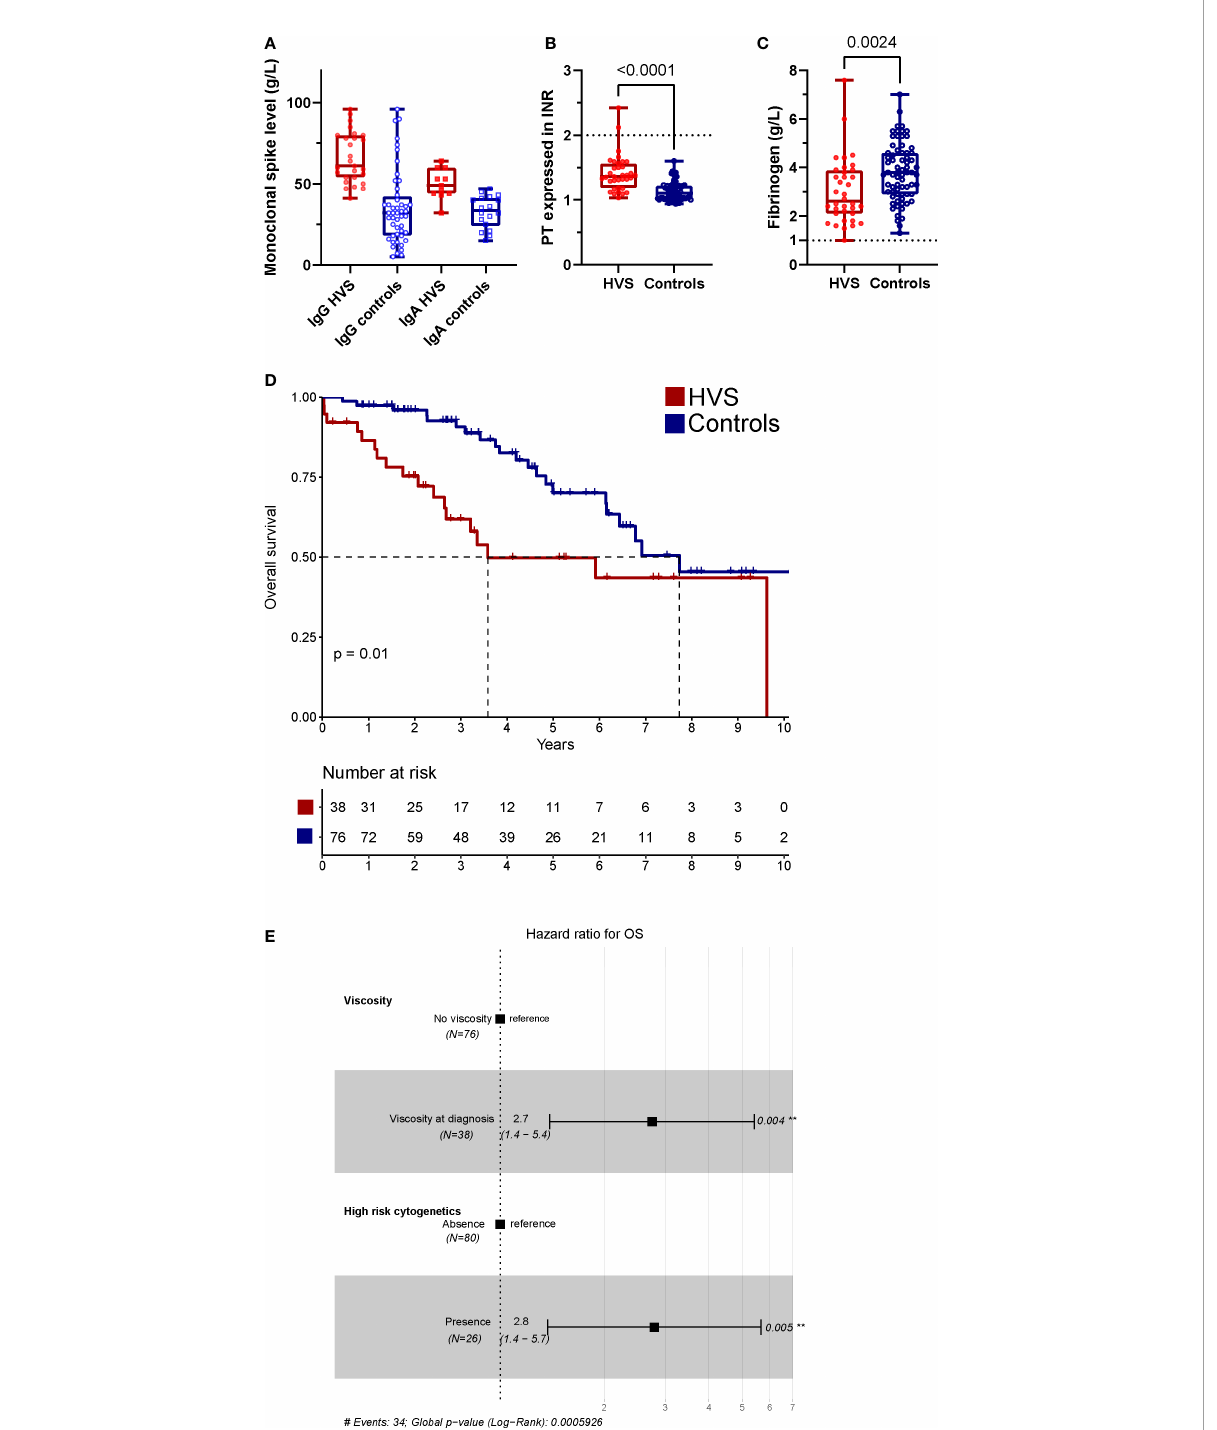
FIGURE 3 Comparison to NDMM controls. (A) Monoclonal protein level between HVS and controls for each sub-type (B, C) PT expressed in INR (B) and fi brinogen (C) levels between HVS and control NDMM. Line represents in each fi gure the cut-off of increase bleeding risk in clinical (D) OS of HVS (red) and controls (blue) patients, (E) Forest plot for OS with fi nal model. In univariate, HVS, cytogenetic risk, ISS and R-ISS have a p < 0.1. Each patient with NDMM and HVS was paired with two NDMM controls without HVS based on sex, age ( ± 5 years), year of diagnosis ( ± 3 years), and fi rst-line MM therapy. The median follow-up for the controls (n=76) was fi ve years (IQR 2.7 –